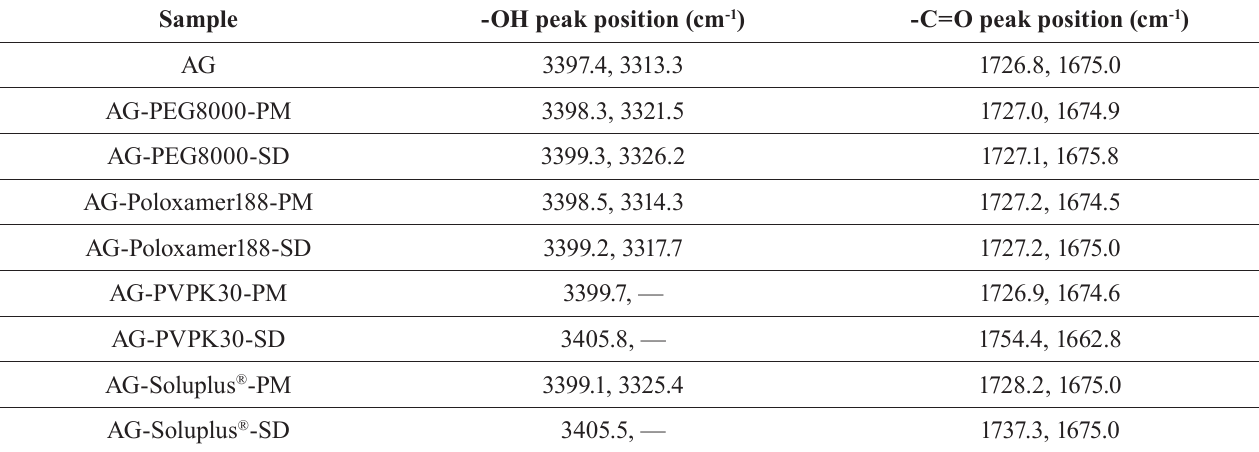
TABLE I - - OH and -C=O peak position of AG in pure AG, PM and SD